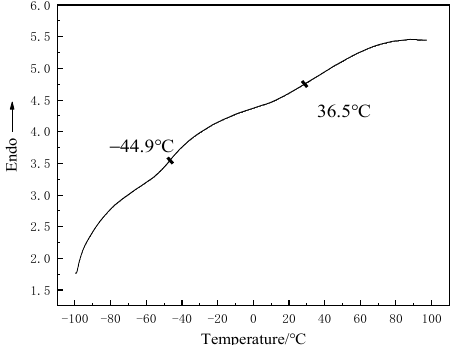
Figure 8. Glass transition temperature of T26 polyurea.